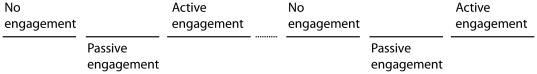
Experimental protocol.Participants alternated between intervals of no engagement (blank screen), passive engagement, and active engagement.